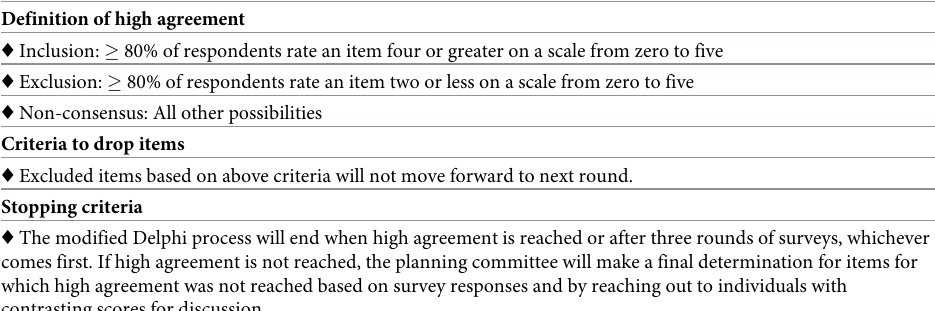
Table 1. Criteria for Delphi methods adapted from Schneider and colleagues